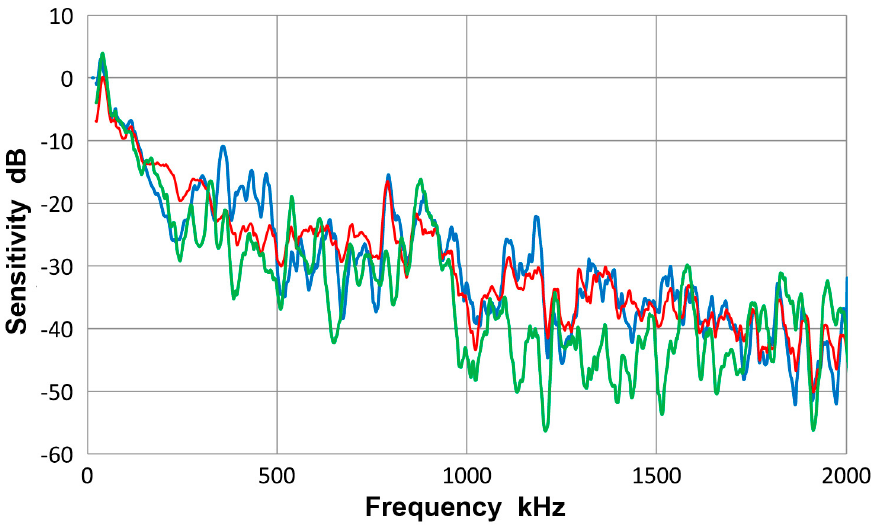
Figure 7. Receiving sensitivity of Olympus V103 transducer. Red -averaged guided wave sensitivity, blue -Lamb waves from symmetric excitation (S) for 12.7 mm plate, green -Lamb waves from asymmetric excitation (A) for the same plate.